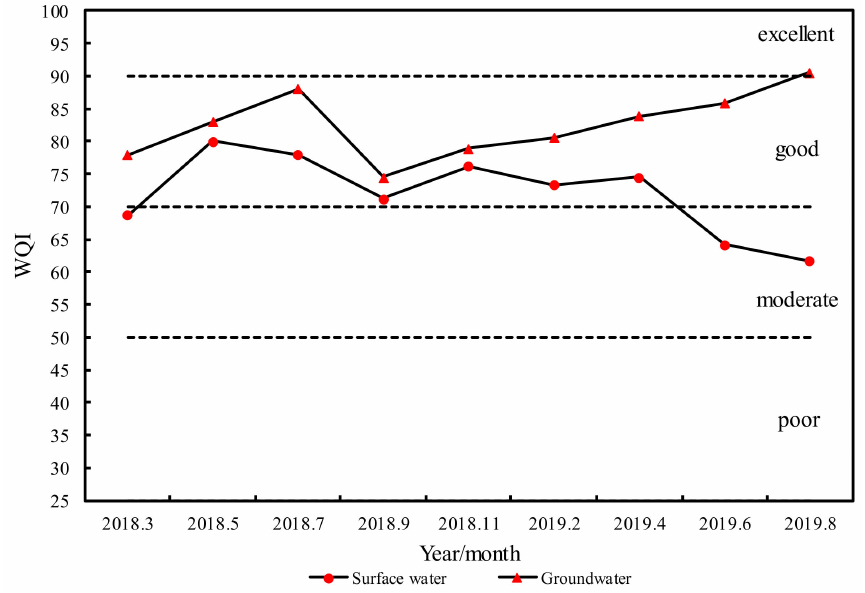
Figure 5. The evaluation results of the water quality index (WQI)